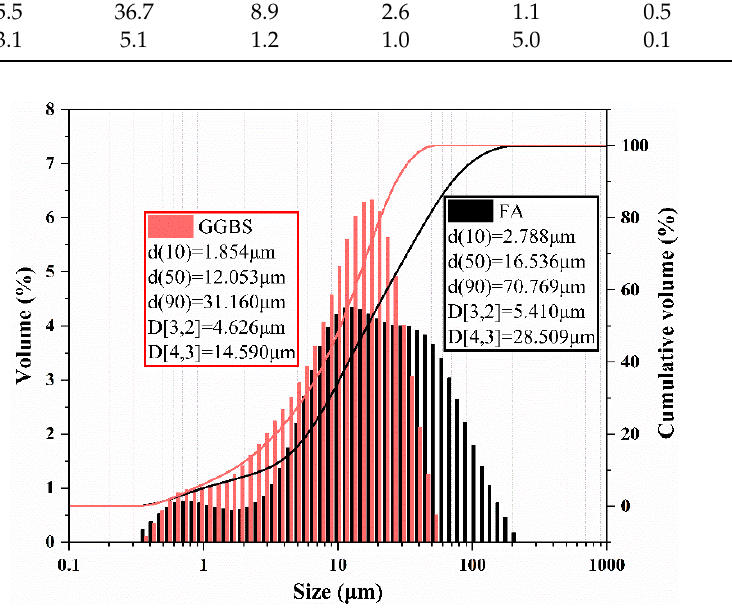
Figure 1. Particle size distribution of cementitious material.